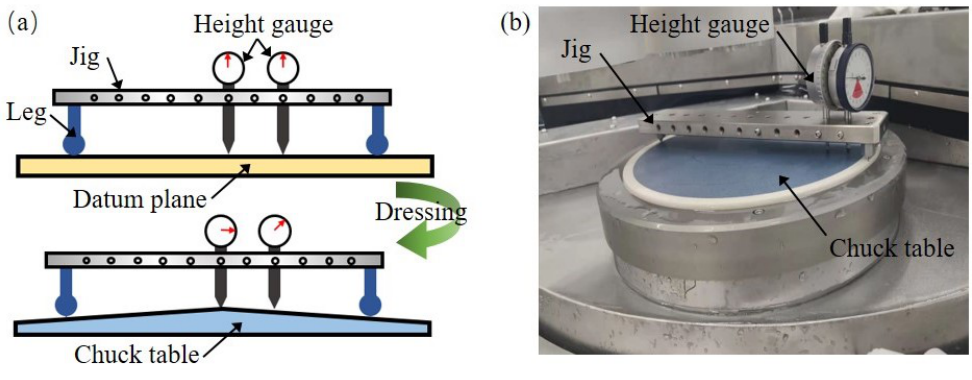
Figure 13. The device for chuck table shape measurement. ( a ) Diagram of the in situ measurement. ( b ) The actual measurement on the grinding tool. ThewaferTTVismeasuredbythethin-filmanalyzer(F50, FilmetricsInc., San Diego, CA, USA)